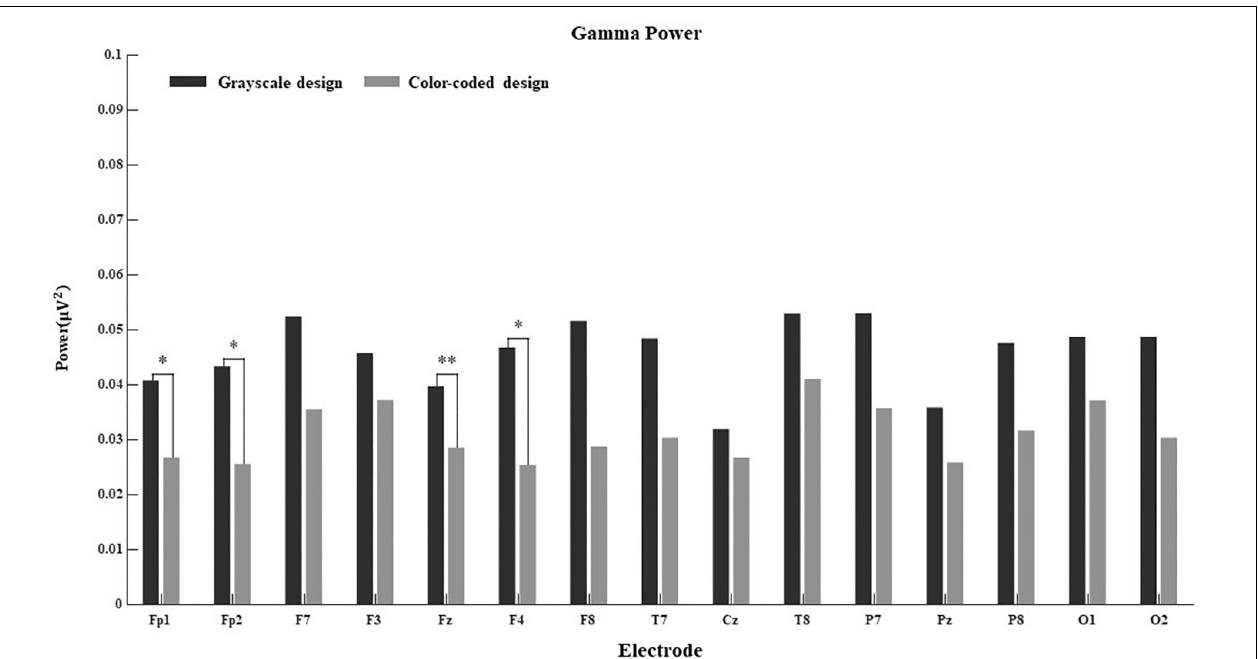
FIGURE 8 | Gamma power for the 15 electrodes in the grayscale and color-coded conditions while watching video lectures ( ∗ p < 0.05, ∗∗ p < 0.01).